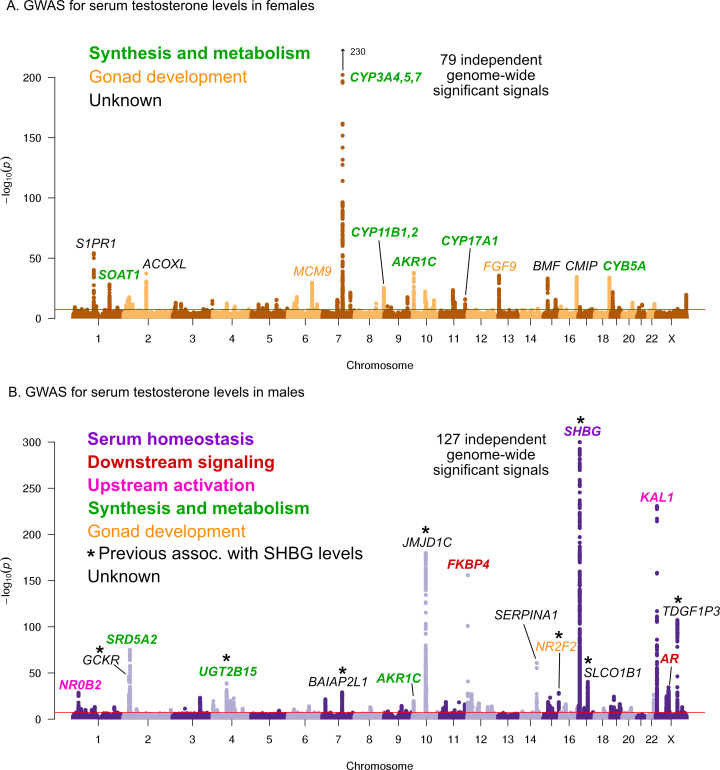
Manhattan plots for testosterone.(A) Females. (B) Males. Notice the low overlap of lead signals between females and males. FAM9A and FAM9B have been previously proposed as the genes underlying the KAL1 locus (Ohlsson et al., 2011).